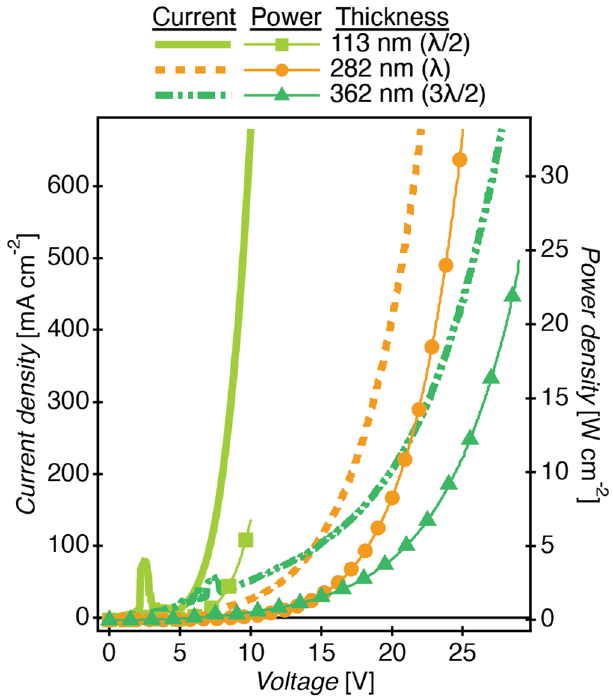
Figure 7. Current density (left axis, solid and dashed lines) and power density (right axis, lines with markers) vs. applied voltage for microcavity OLEDs of thickness 113 nm ( (cid:31) / 2 ), 282 nm ( (cid:31) ), and 362 nm ( 3 (cid:31) / 2 ) representing the three resonance modes. Supplementary Figure S5 shows the same data on a log-log